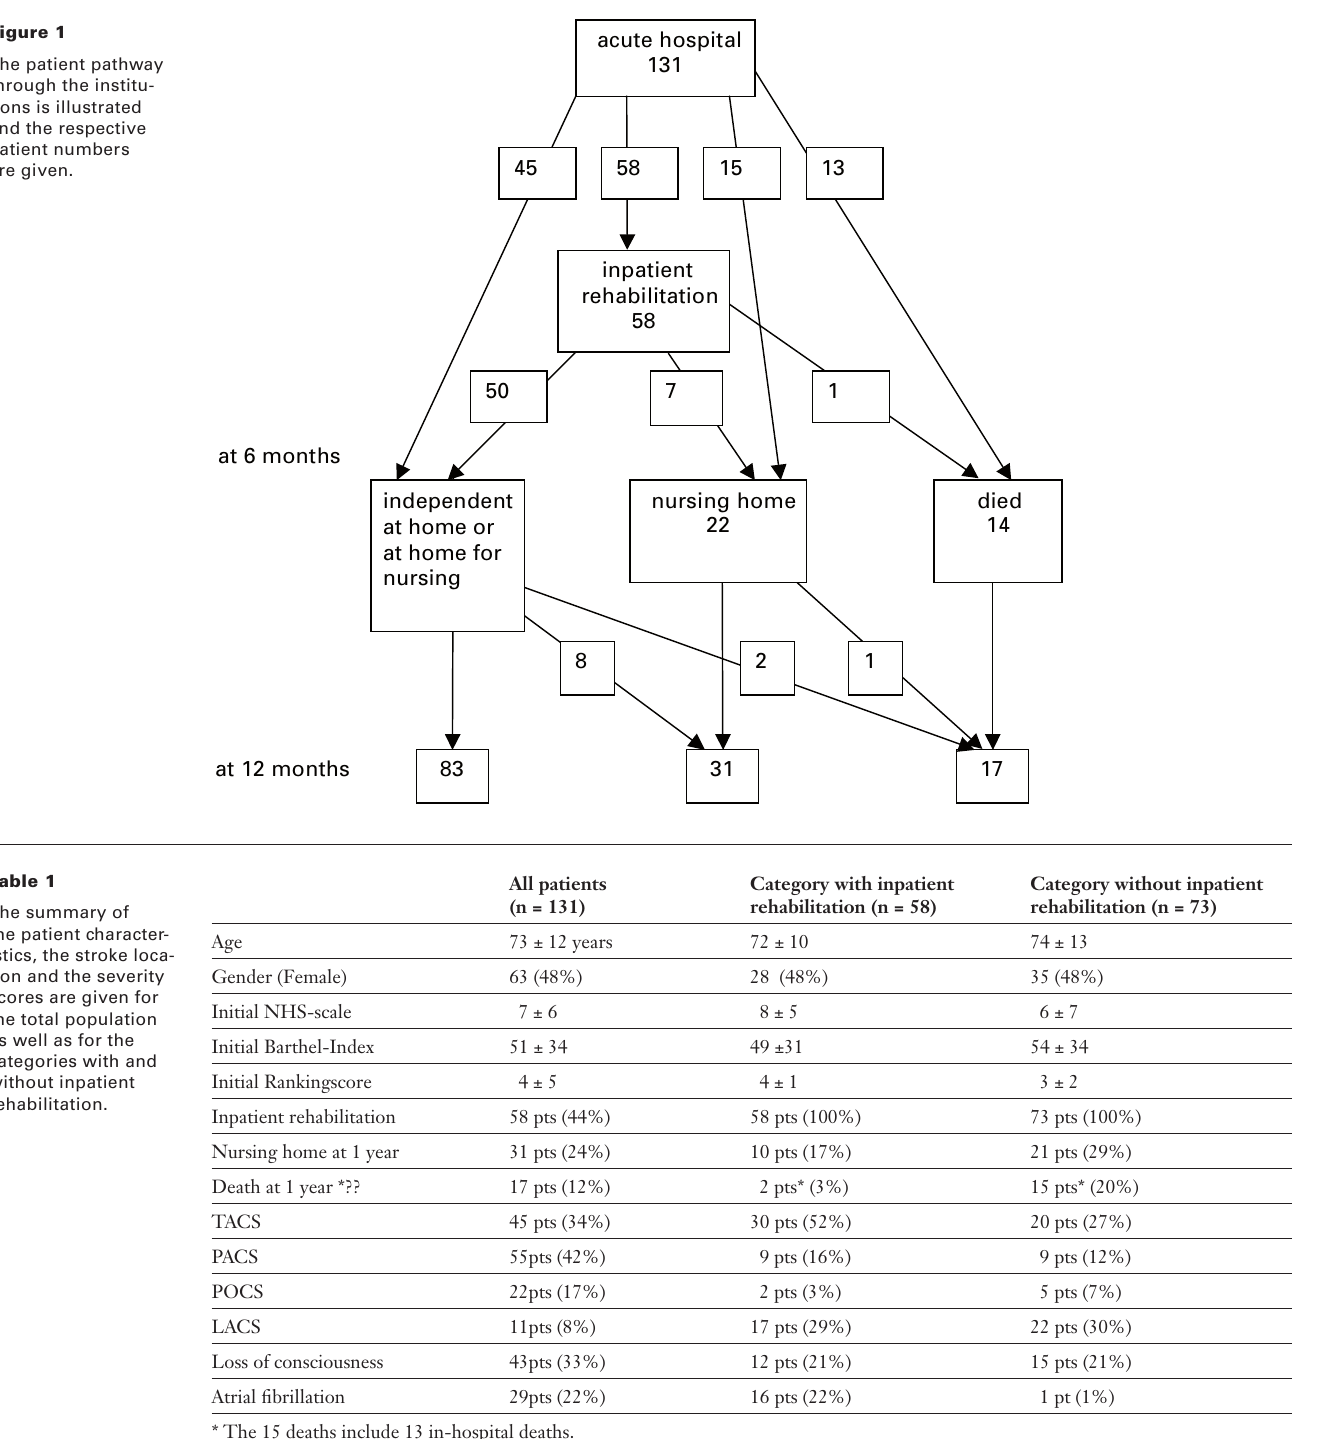
The patient pathway through the institu- tions is illustrated and the respective patient numbers are